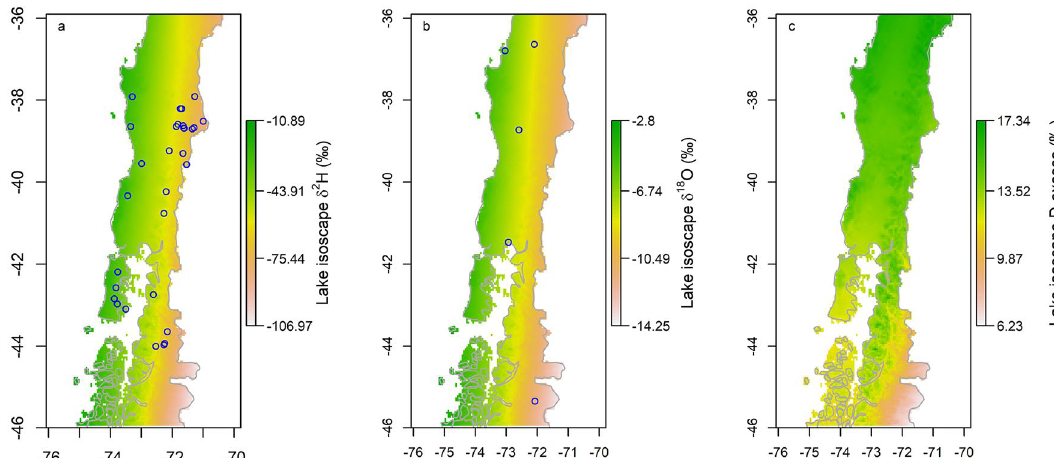
Figure 3. ( a ) Multivariate isoscape model predicted δ 2 H (color scale) for our study region, based on isotope values measured at lake locations (circles) ( b ) Predicted δ 18 O (color scale) and IAEA GNIP station locations (circles) ( c ) Predicted deuterium excess (color scale), all at 0.05° resolution. Map generated using QGIS 21 software.